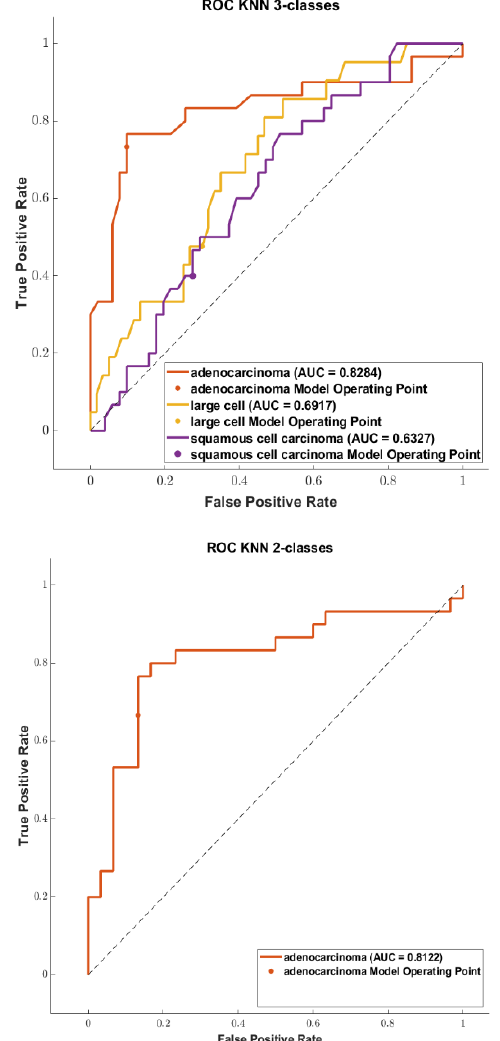
Figure 14. ROC curves: ( top ) The 4-classes datasets, ( middle ) 3-classes datasets, and ( bottom ) 2-classes datasets.